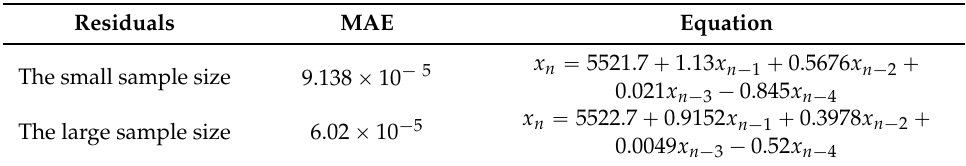
Figure 5. Comparison the forecasted electric load of training and test data by the QPSO-SVR model for the data-I of sample data in Case 2: ( a ) One-day ahead prediction from 13 to 14 January 2015 are performed by the model; ( b ) One-week ahead prediction from 2 to 15 February 2015 are performed by the model. Table 5. Summary of results of the AR forecasting model for Data-II in Case 2.